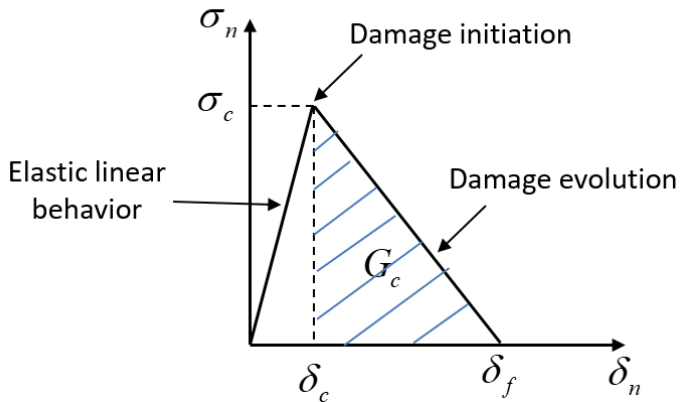
Figure 9. Bi-linear traction separation function for modeling damage at the bonded interface.